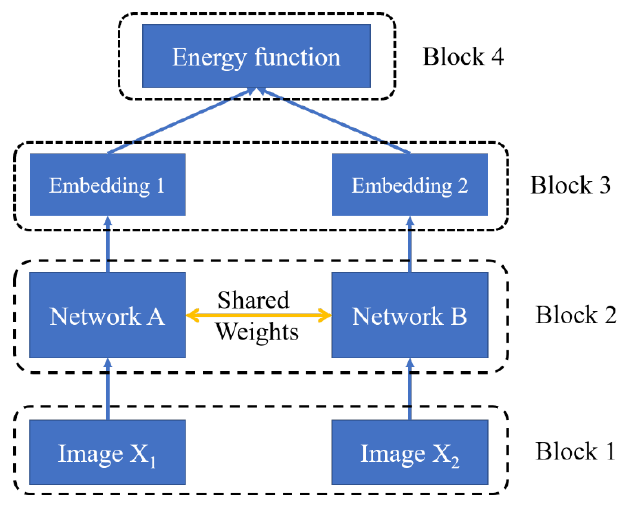
Figure 3. The workflow of the Siamese network.